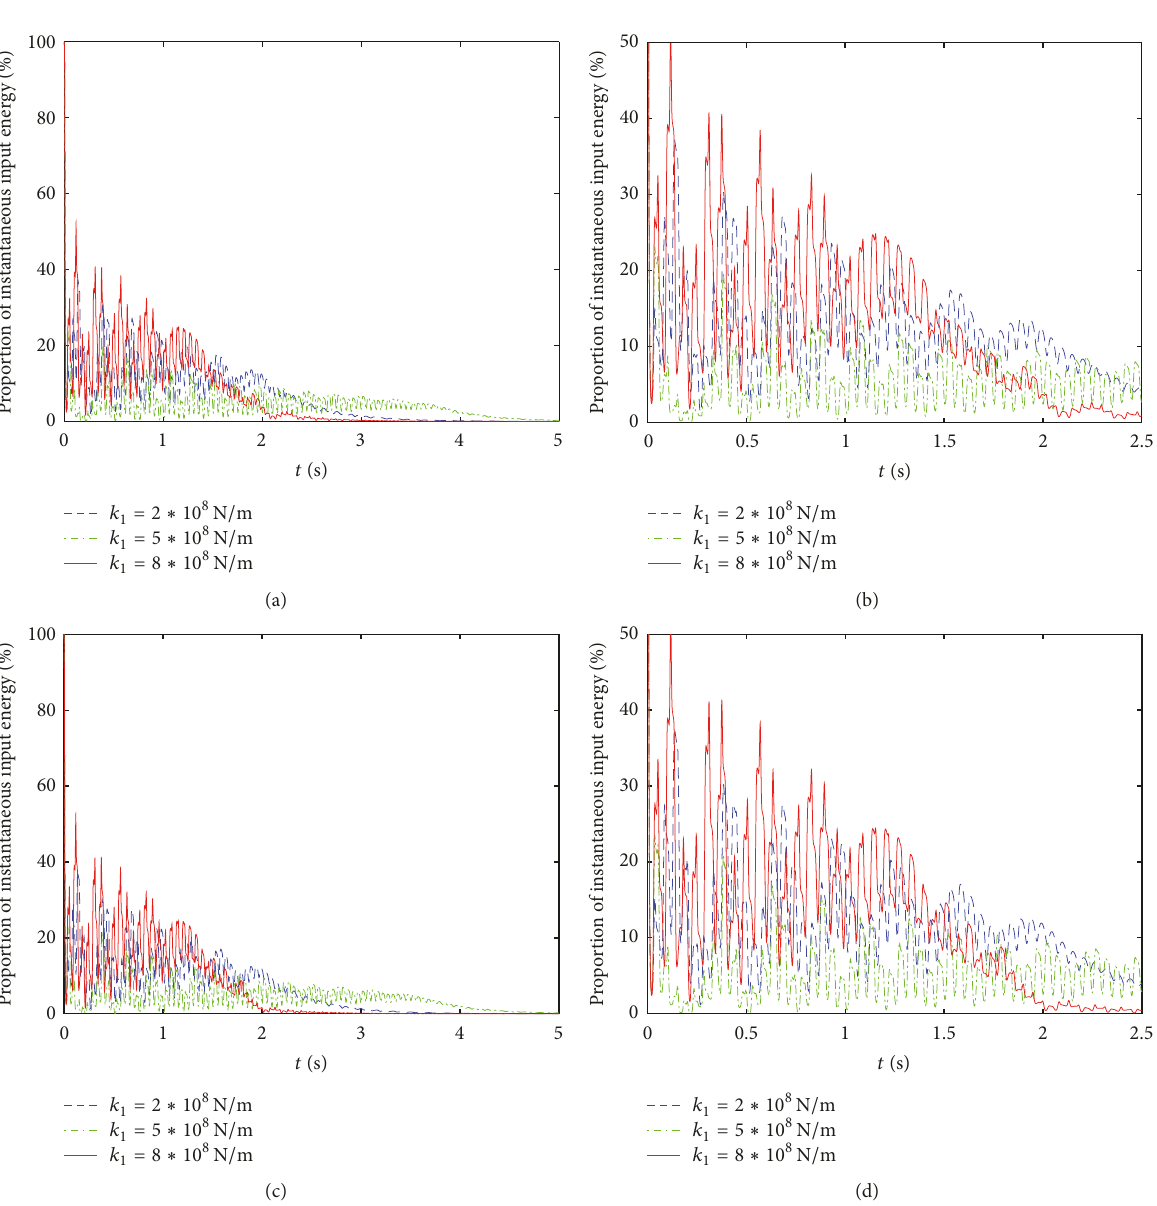
Figure 6: (a) The proportion of instantaneous input energy and (b) its enlargement of configuration 1; (c) the proportion of instantaneous input energy and (d) its enlargement of configuration